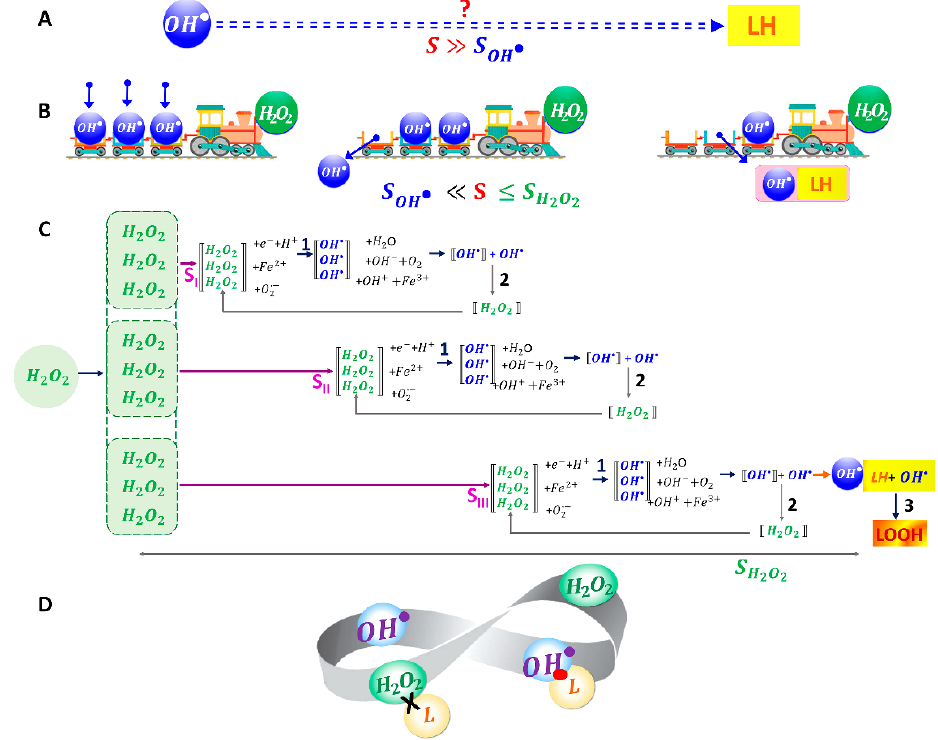
Figure 4. Mechanochemical synergism of 𝑂𝐻 • and 𝐻 (cid:2870) 𝑂 (cid:2870) during action on the RBC membrane. ( A